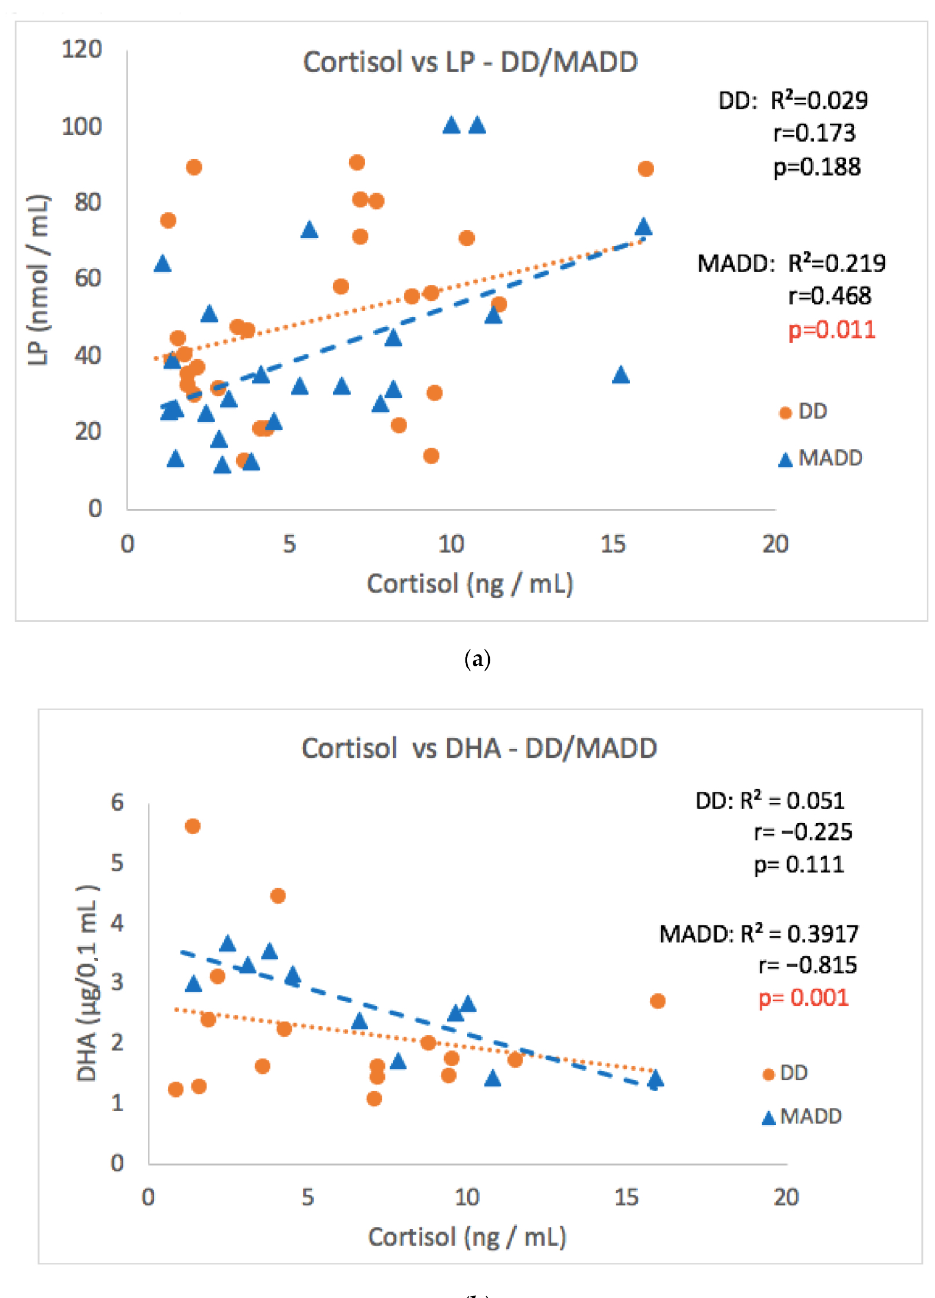
Figure 6. Correlations between morning cortisol concentrations versus LP ( a ) and DHA ( b ) at the baseline in the DD and MADD subgroups. LP—lipoperoxides, DHA—docosahexaenoic acid, DD—depressive disorder subgroup, and MADD–mixed anxiety and depressive disorder